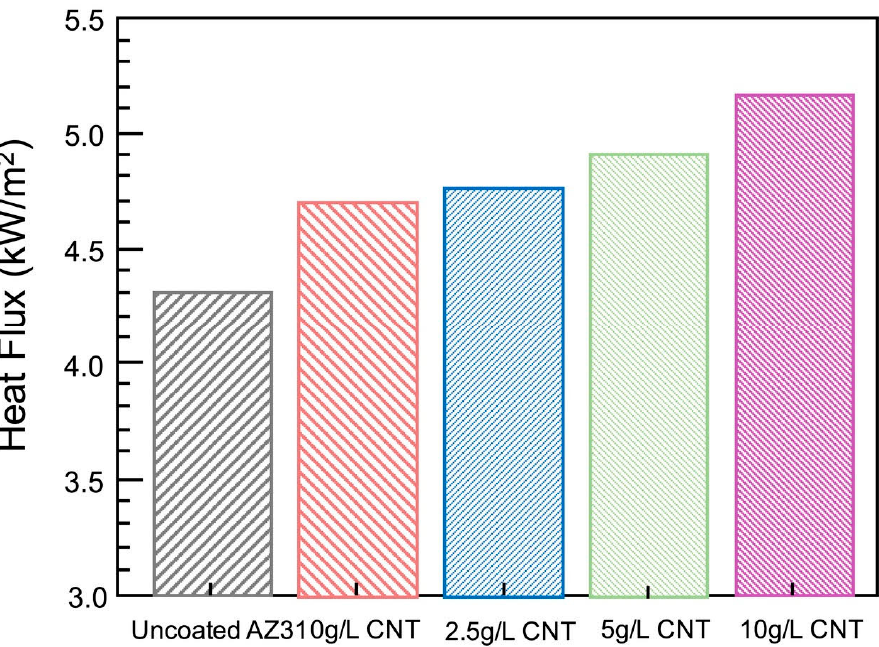
Figure 13. Heat flux of AZ31 Mg substrate and PEO coatings with various CNT concentration. Adapted from [129].